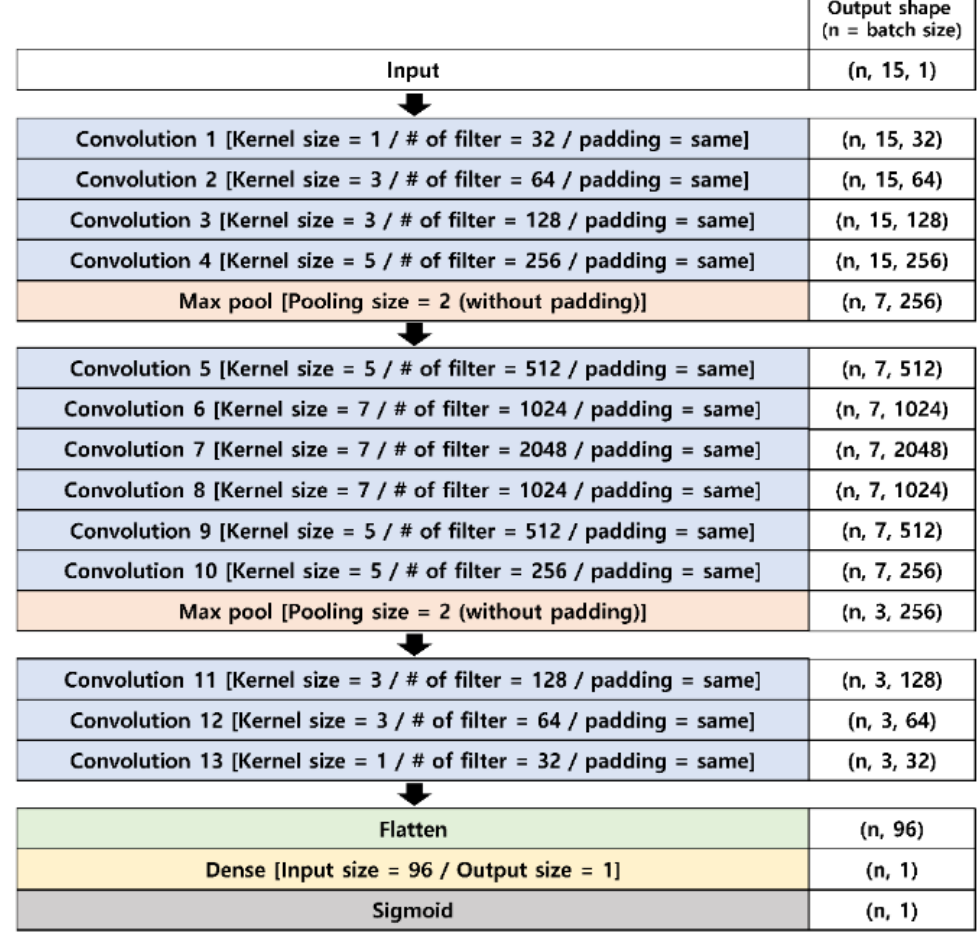
Figure 3. Architecture of the developed CNN model. All convolution layers used Rectified Linear Unit (ReLu) as the activation function.